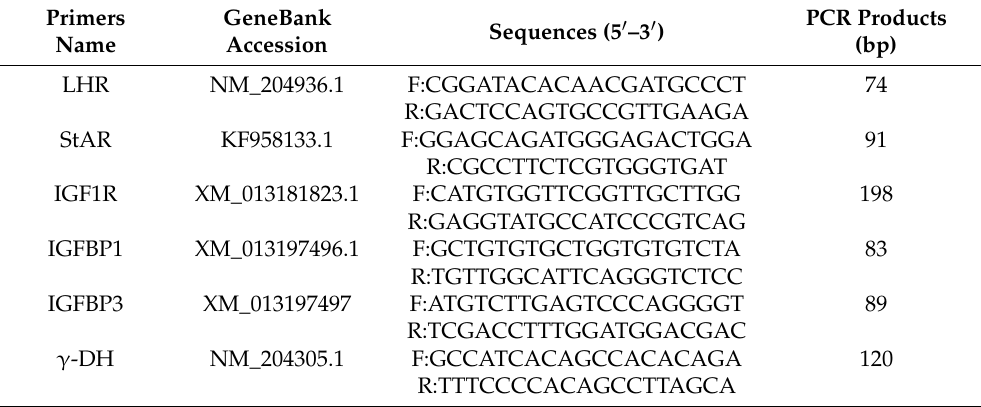
Table 1. Primer sequences used in this study.